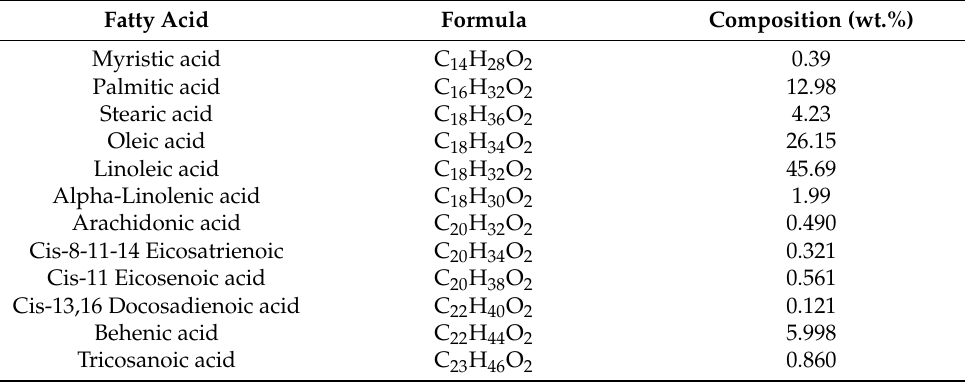
Table 1. Sea mango oil’s fatty acid profile.